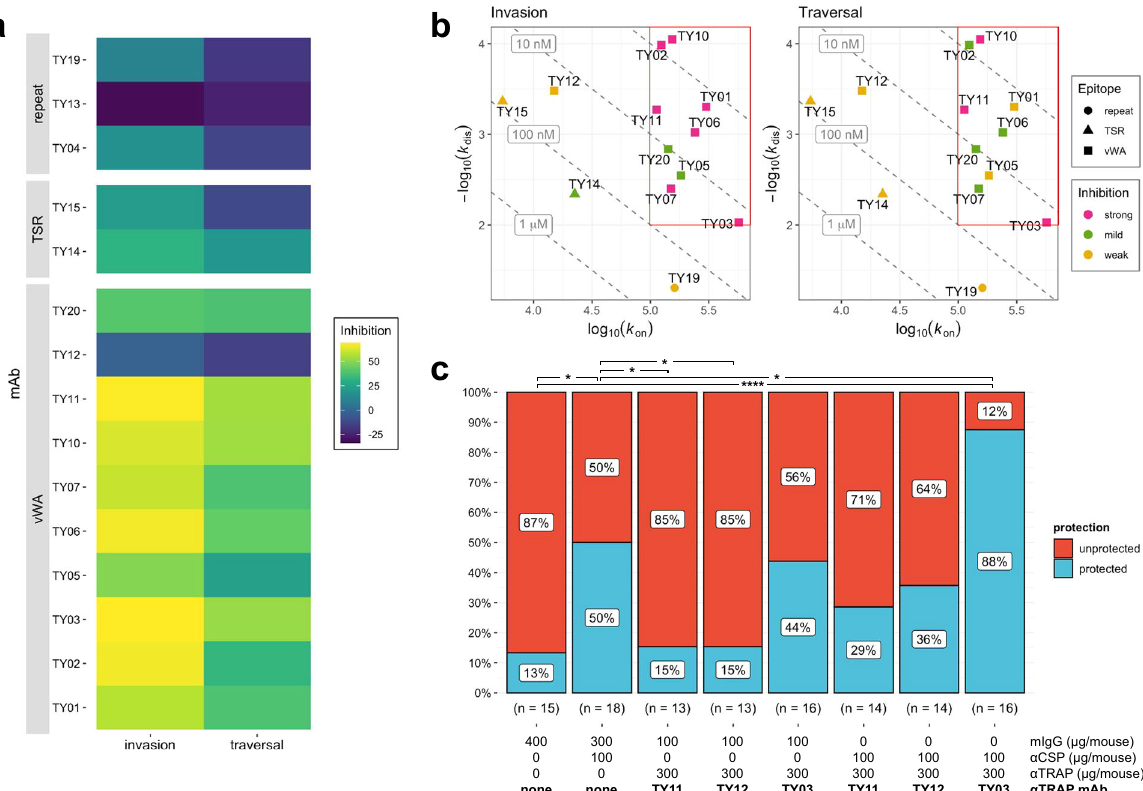
Fig. 3 Effects of PyTRAP monoclonal antibodies on parasite activity. a Each mAb was assessed for in vitro function of inhibition of invasion and traversal. In each case, mean values of % inhibition (i.e., 100% – invasion or traversal value) from the 100-µg/mL mAb concentrations (bar plots with these and additional conditions shown in Suppl. Fig. 1) are represented on a color axis. b Binding kinetics for each mAb was measured by BLI and shown as kinetic maps with gray dashed diagonal contour lines labeled with the corresponding K d values and symbols representing the characterized epitopes for invasion (left) and traversal (right) inhibition. Higher-af fi nity (i.e., those possessing lower K d values) mAbs are closer to the upper-right corner of this plot. Symbol color coding represents “ strong ” inhibition for mean values ≤ 50%, “ mild ” inhibition for values ≤ 70%, and “ weak ” for mean values >70% observed at the 100-µg/mL concentration. The red box highlights the region of the kinetic plots containing the values for mAbs that showed strong inhibition in invasion and traversal assays. c Summarized sterile protection ratios following passive-transfer-challenge experiments (number of animals in each group is shown below the corresponding bar, individual values shown in Table 1). For c , * is p ≤ 0.05 and **** is p ≤ 0.0001; values reported were not adjusted for multiple comparisons due to small group sizes and limited